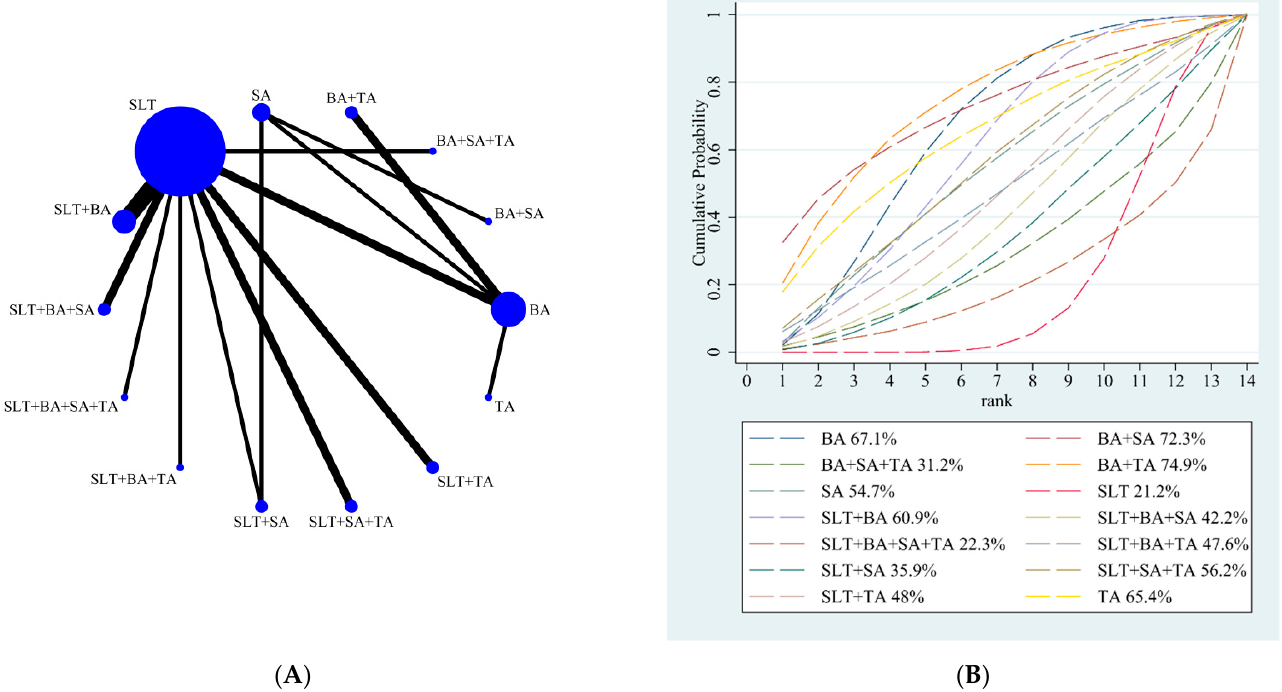
Figure 3. ( A ) NMA figure for the comprehension score. ( B ) SUCRA plot for the comprehension score.